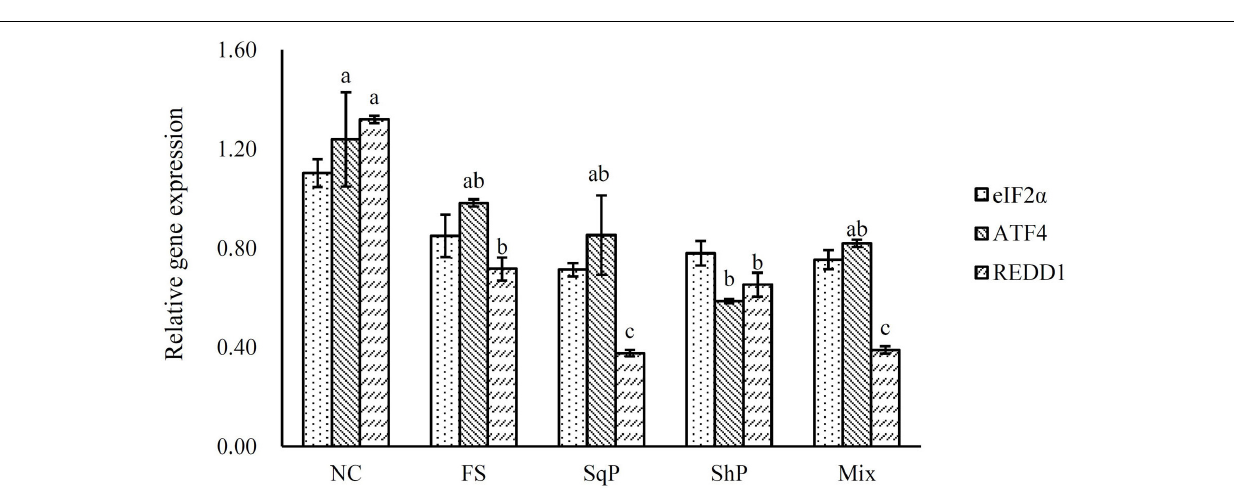
FIGURE 3 | The expression of AAR pathway-related genes, elongation initiation factor 2 α (eIF2 α ), activating transcription factor 4 (ATF4), and regulated in development and DNA damage responses 1 (REDD1) of largemouth bass fed the experimental diets for 81 days. Values (means ± standard error of the mean, SEM) in bars that have the same letter are not significantly different ( P > 0.05; Tukey’s test) among treatments ( N =